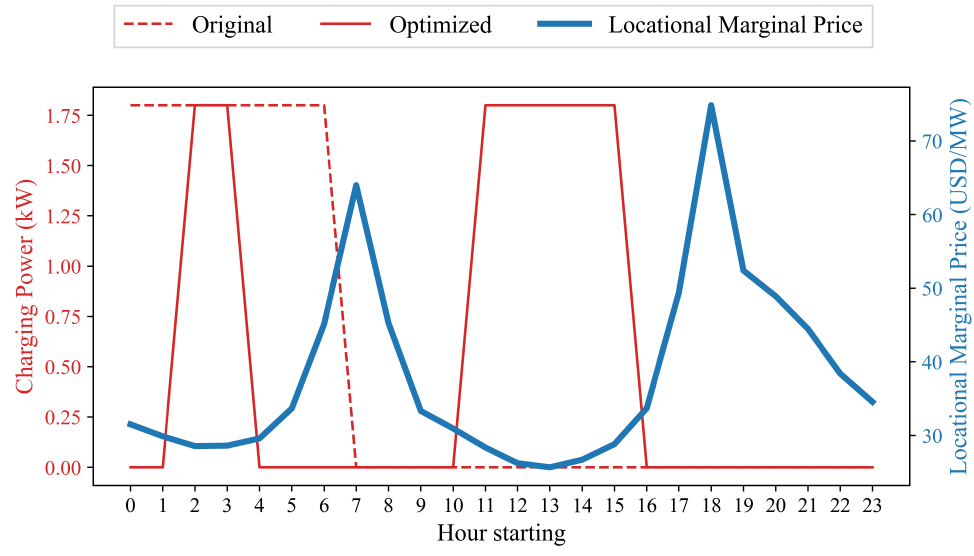
Figure 5. Sample trajectories of charging powers in the original data and the fixed-location model solution.